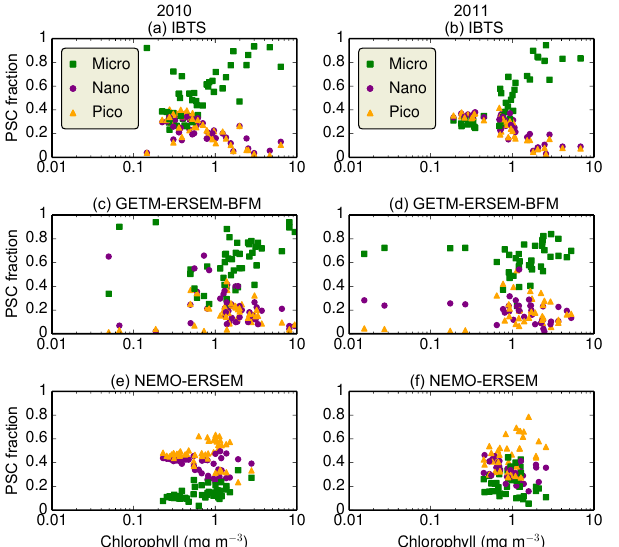
Figure 11. Phytoplankton size class (PSC) distribution as a func- tion of chlorophyll concentration, plotted at each IBTS observation location in 2010 (a, c, e) and 2011 (b, d, f) from the IBTS observa- tions (a, b) , GETM-ERSEM-BFM (c, d) , and NEMO-ERSEM (e, f) .